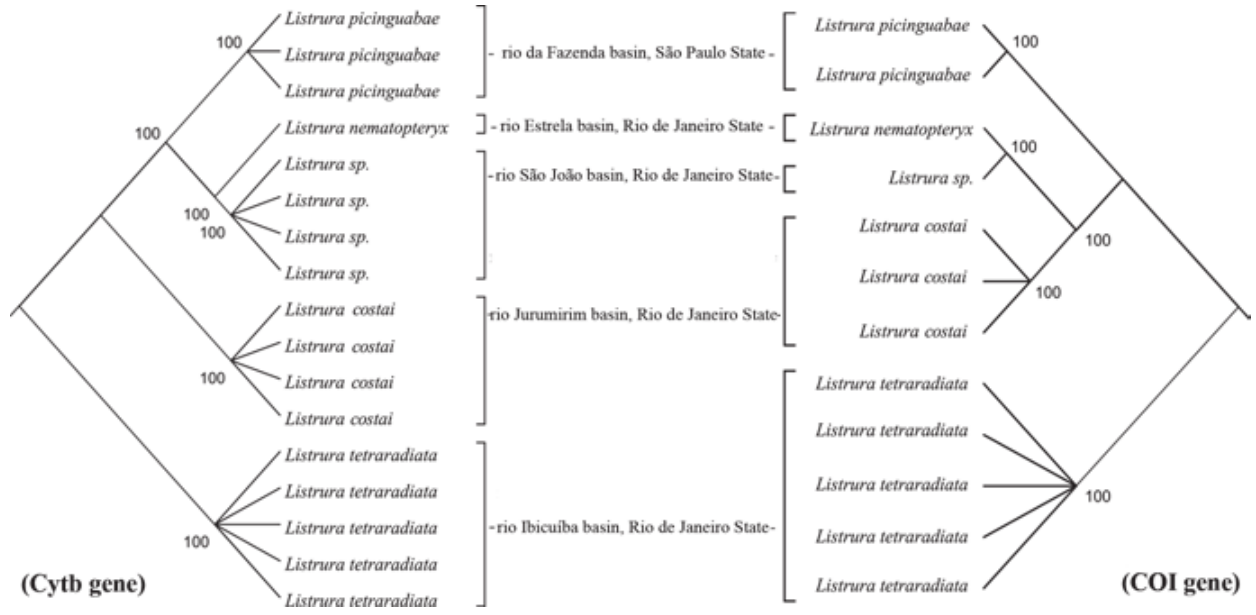
Fig. 9. Two Maximum Parsimony consensus trees for the mitochondrial DNA genes Cytochrome b (left) and Cytochrome Oxidase C subunit I (right), respectively. Numbers indicate the bootstrap values with 1,000 pseudoreplicates. Segments with values < 50% were condensed and values not